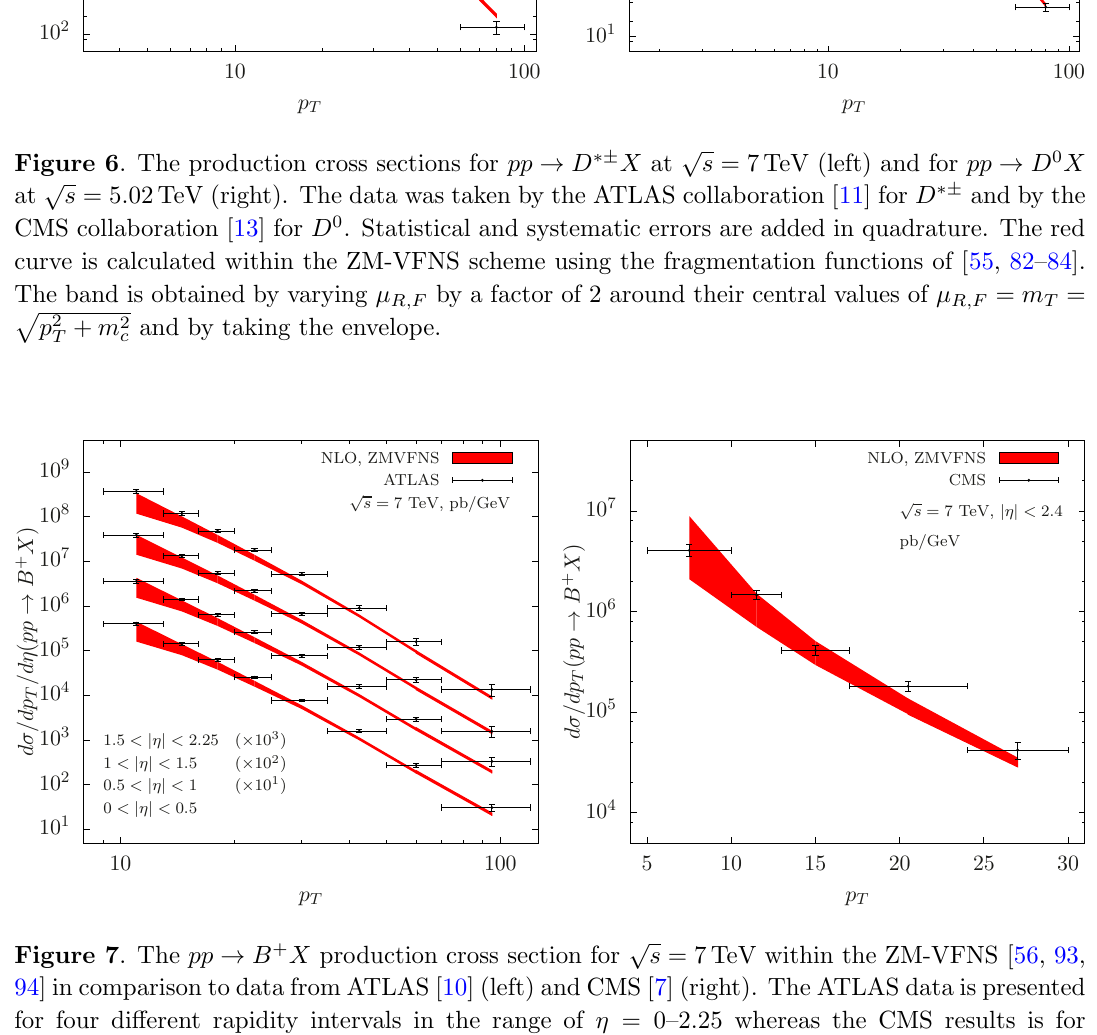
Figure 7 . The pp ! B + X production cross section for 94] in comparison to data from ATLAS [10] (left) and CMS [7] (right). The ATLAS data is presented for four di(cid:11)erent rapidity intervals in the range of (cid:17) = 0{2 : 25 whereas the CMS results is for j (cid:17) j < 2 : 4. Statistical and systematic errors are added in quadrature. The NLO calculation is shown in red where the factorization and renormalization scales are chosen as (cid:22) R;F = m T = The band is obtained by varying (cid:22) R;F independently by a factor of 2 around their central values and by taking the